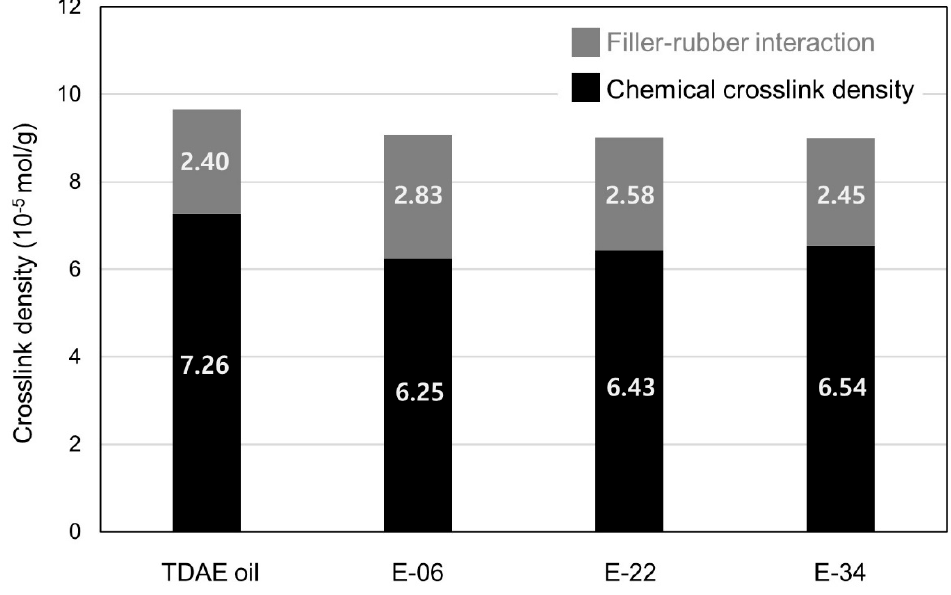
Figure 6. Crosslink densities of the vulcanizates. Table 6. Weight loss and crosslink densities of the vulcanizates (units: 10 − 5 mol/g).